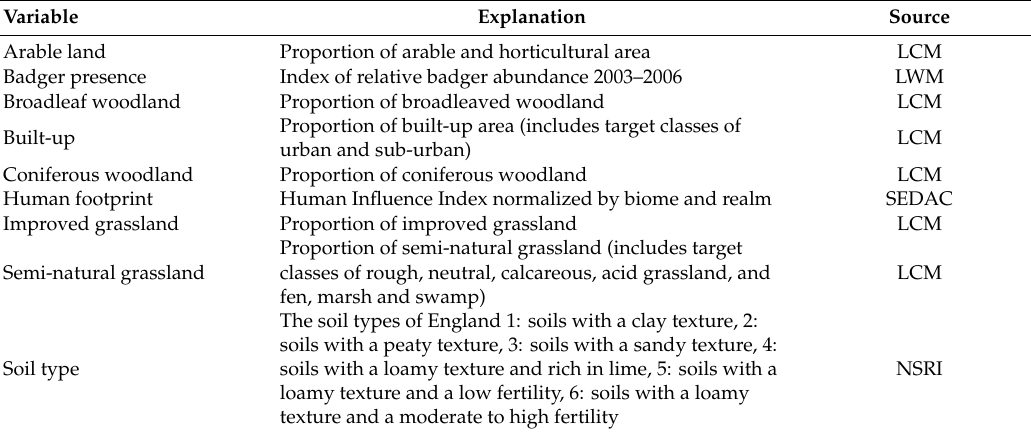
Table 1. Explanation of the response variables used (LCM: Land Cover Map 2000 and 2007, NSRI: National Soil Resource Institute, LWM: Living with Mammals survey, SEDAC: Socioeconomic Data and Applications Center [see text for explanation]) to study their impact on the relative hedgehog abundance throughout England in 2005–2006. Some land classes from the LCM were not included because they were extremely rare (absent from > 90% of grid cells) or were not suitable, such as “Mountain, heath, bog”, “Saltwater”, “Freshwater”, and “Coastal”. Variable Explanation Source Arable land Proportion of arable and horticultural area LCM Badger presence Index of relative badger abundance 2003–2006 LWM Broadleaf woodland Proportion of broadleaved woodland LCM Proportion of built-up area (includes target classes of LCM Built-up urban and sub-urban) Coniferous woodland Proportion of coniferous woodland LCM Human footprint Human Influence Index normalized by biome and realm SEDAC Improved grassland Proportion of improved grassland LCM Proportion of semi-natural grassland (includes target Semi-natural grassland classes of rough, neutral, calcareous, acid grassland, and LCM fen, marsh and swamp) The soil types of England 1: soils with a clay texture, 2: soils with a peaty texture, 3: soils with a sandy texture,